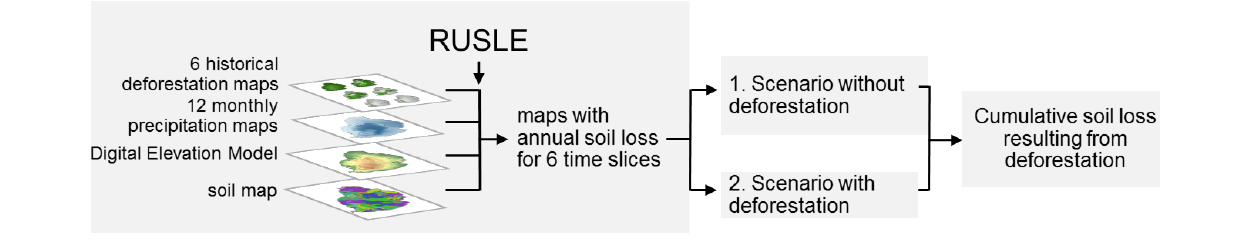
Fig. 3. Workflow illustrating the RUSLE-based analysis of cumulative soil loss for two scenarios of deforestation on Mauritius.